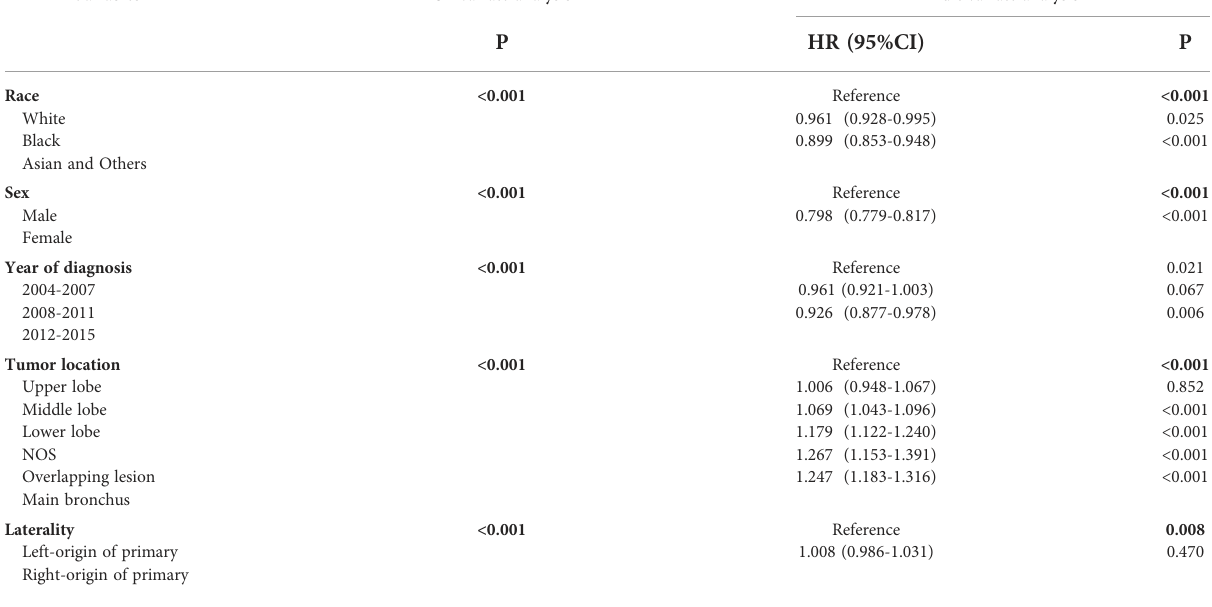
TABLE 3 Univariate and multivariate analyses of OS in N0 NSCLC patients. Variables Univariate